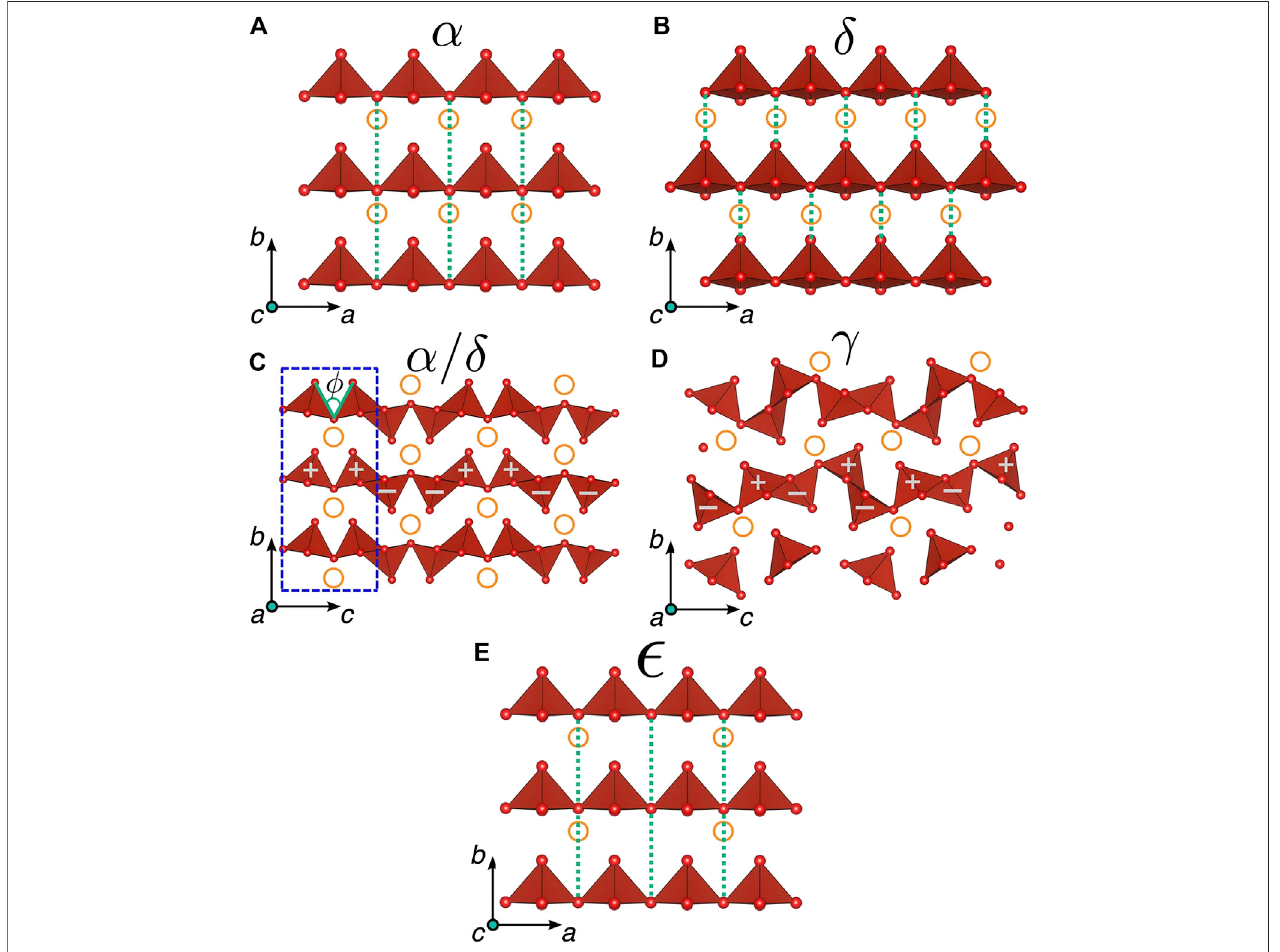
FIGURE 2 | (A) α and (B) δ polymorphs of orthorhombic V 2 O 5 are shown along the c -axis (shown to a depth of c /2 for viewing clarity) and (C) along the a -axis, which, compared to the (D) γ polymorph, has a different orientation of VO 5 pyramids as denoted by the “ + ” and “ − ” symbols along the c -axis. Hollow orange circles correspondtotheintercalation sites, thegreendottedlines showthedifferences inlayerstacking,and thedashed blue rectangle inpanel (C) indicatesadistanceof c /2. Panel (E) illustrates the ϵ phase corresponding to a speci fi c ordering of Mg atoms in α -V 2 O 5 at half magnesiation, where alternate intercalant sites are occupied in the a -axis, as indicated by the orange circles. The schematics here correspond to “ supercells ” of the respective polymorph unit cells. Reprinted (adapted) with permission from Chem. Mater. 2015, 27, 10, 3733 – 3742. Copyright 2015 American Chemical Society.